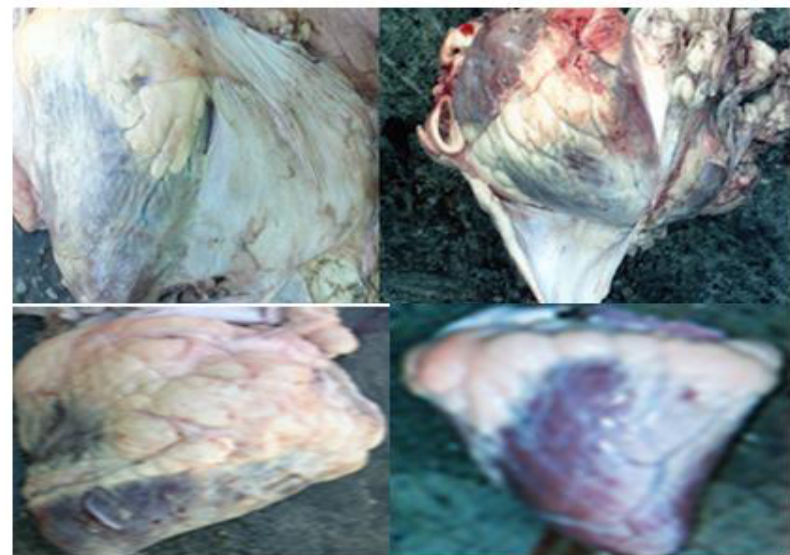
Figure 5. Traumatic carcass (Tissue rupture with hemorrhage).